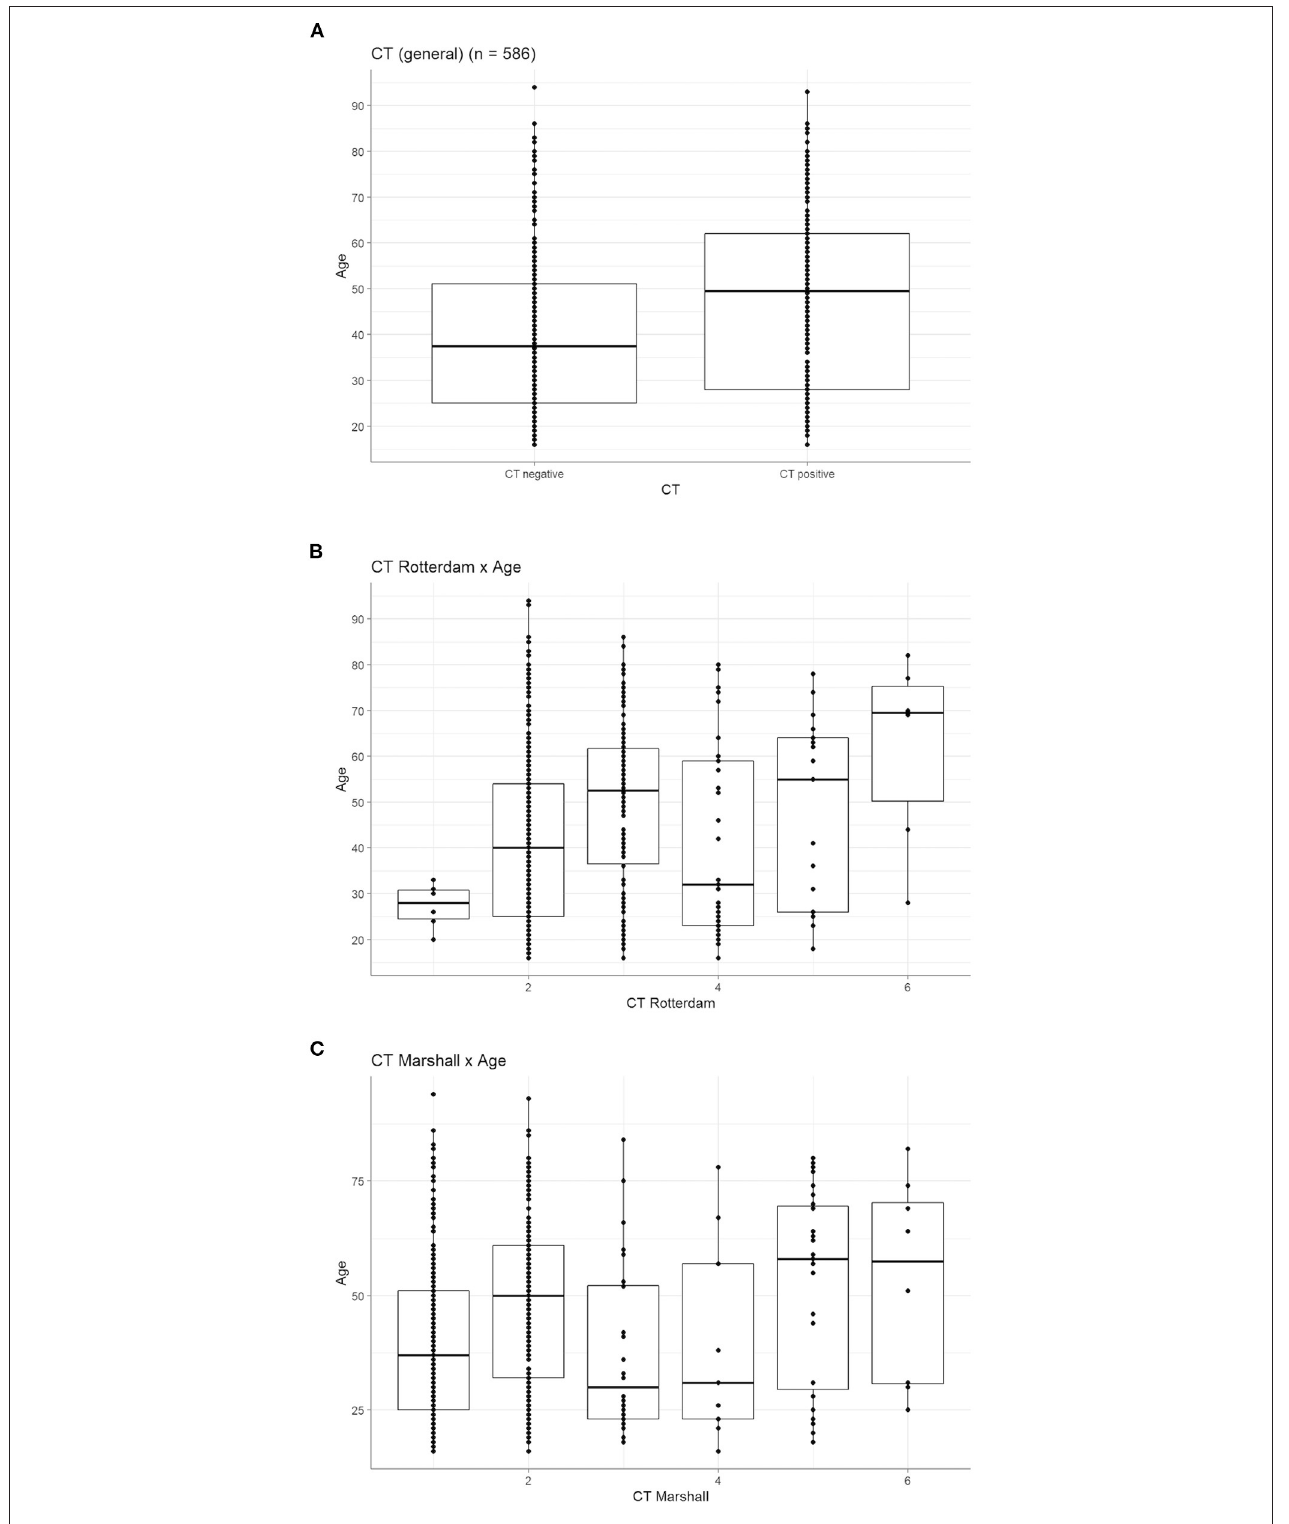
FIGURE 2 | Age correlates with worse CT pathology. (A) Age is significantly higher in those with a positive diagnosis of CT pathology (Welch’s t = 5.61, p < 0.0). (B) Age significantly differed across the six levels of the Rotterdam CT score [ F (1,584) = 17.34, p < 0.001] and the (C) six levels of the Marshall CT score [ F (1,584) = 18.25, p < 0.001]. For both scores, the two highest scores (indicative of more severe injury) have a higher median age than all other CT scores.